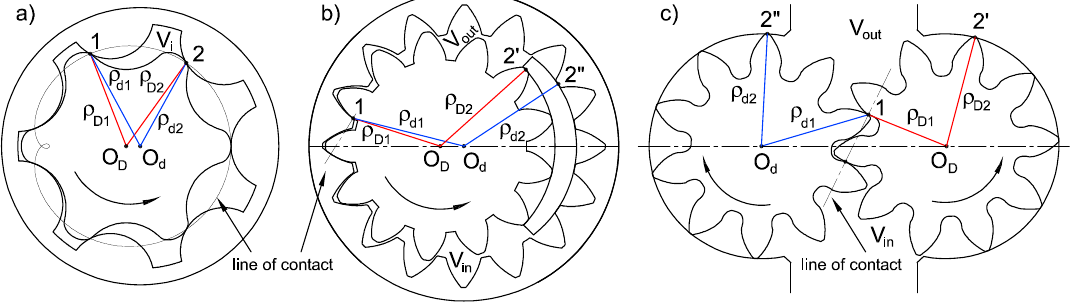
Figure 14. ( a ) Application of the vector-ray method for a gerotor pump with SC method; ( b ) for a crescent pump with MC method; ( c ) for an external gear pump with MC method.